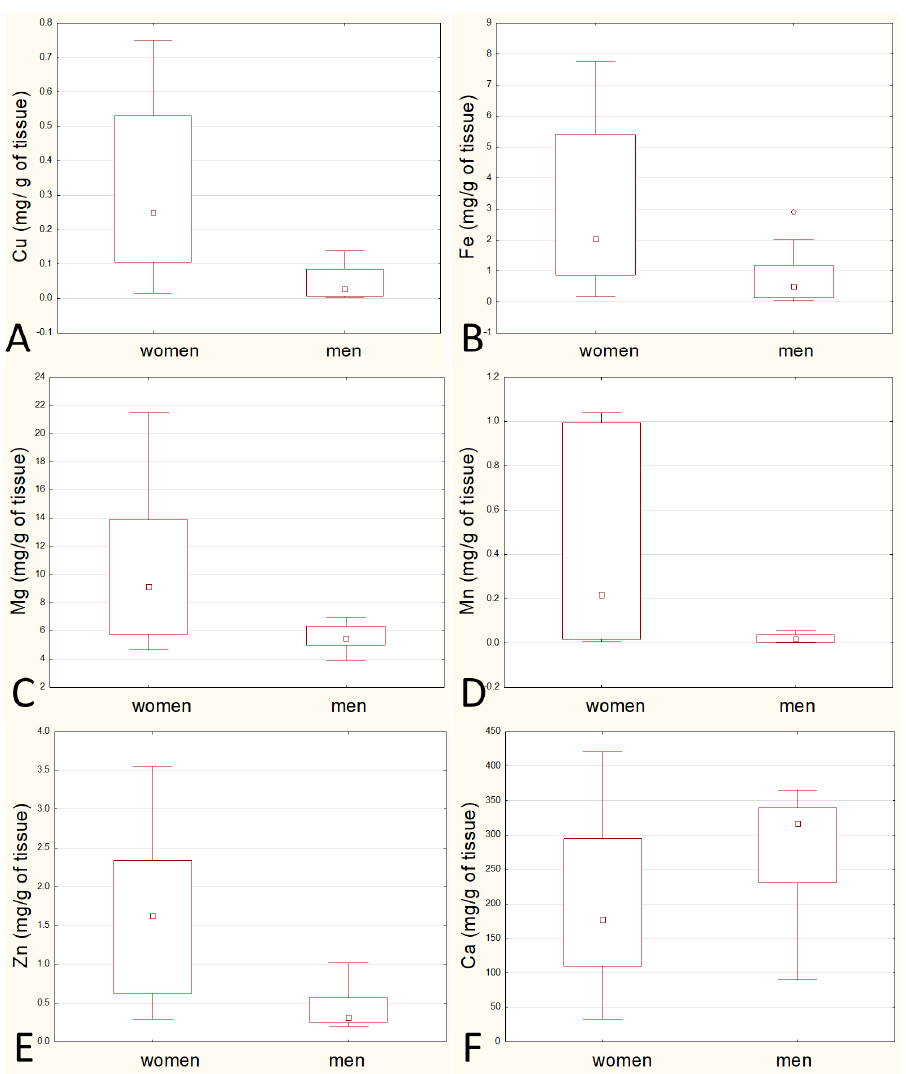
Figure 2. Comparison of the content of elements between the sexes: comparison of the content of copper ( A ), iron ( B ), magnesium ( C ), manganese ( D ), zinc ( E ) and calcium ( F ).